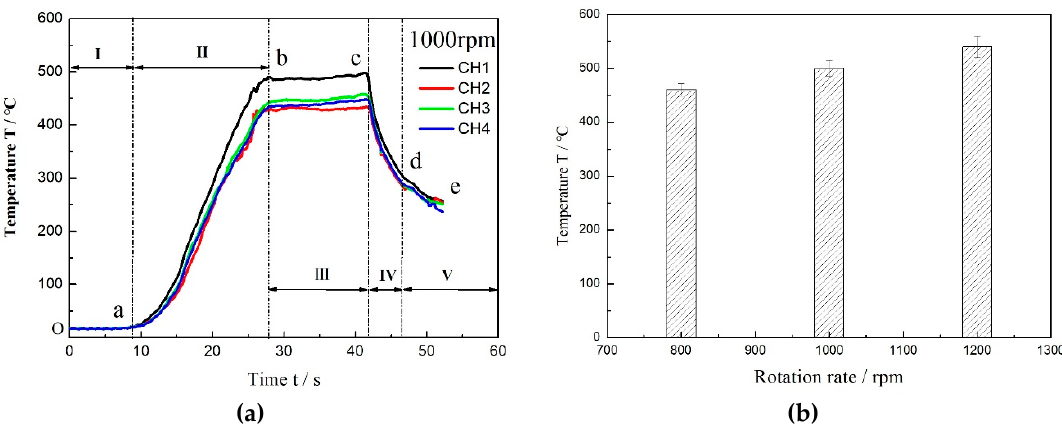
Figure 4. The real-time temperature–time curves ( a ) and histogram of maximum welding temperature ( b ) of dissimilar Al/steel keyhole-free FSSW process.